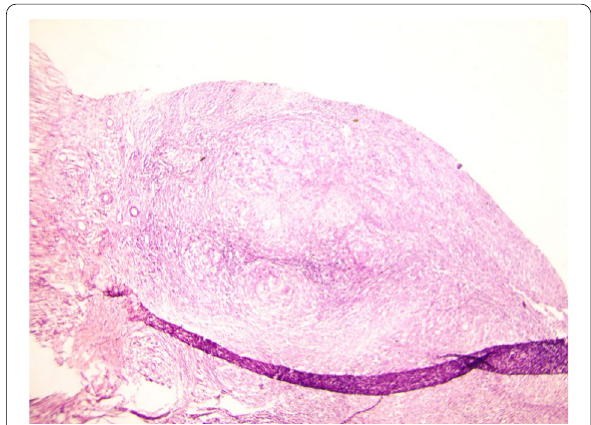
Fig. 5 Photomicrograph showing epitheloid granuloma with multinucleated Langhans-type giant cells (H&E stain,